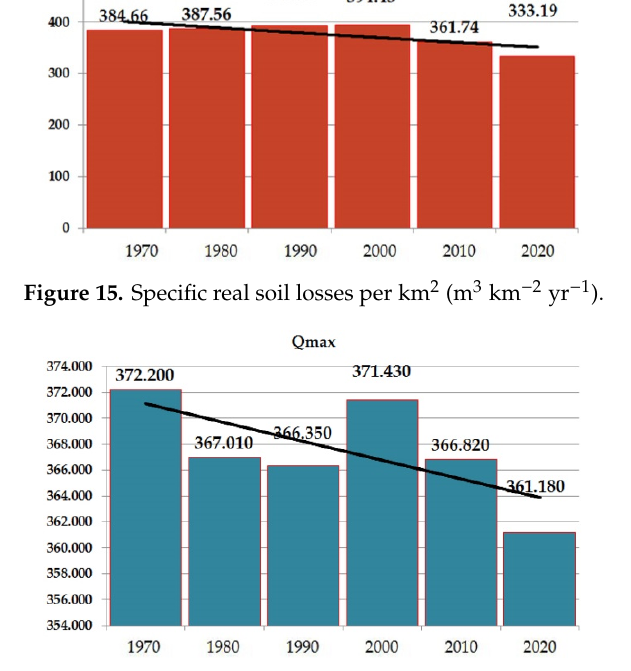
Figure 16. Calculated Peak discharge for the studied basin (m 3 s − 1 ). Table 5. The IntErO report of Inputs for the Miocki Potok river basin.